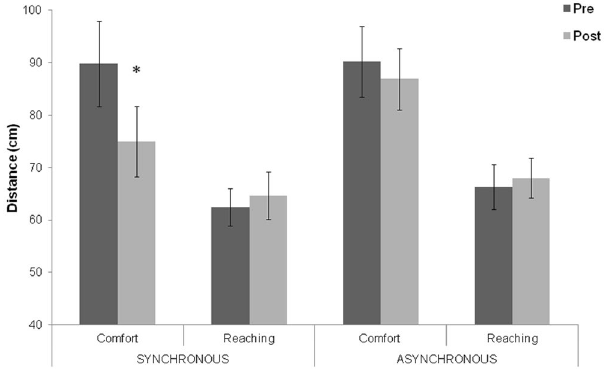
Figure 2. Effects of visuotactile stimulation on comfort and reaching-distance. Statistical comparison of mean distance (cm) in the two tasks (comfort and reaching judgment), in the stimulation conditions (synchronous and asynchronous visuotactile stimulation), and in the two sessions (pre- and post-visuotactile stimulation). Error bars indicate standard errors of the mean. The asterisk indicates a significant difference before and after invisible body illusion in the synchronous condition.